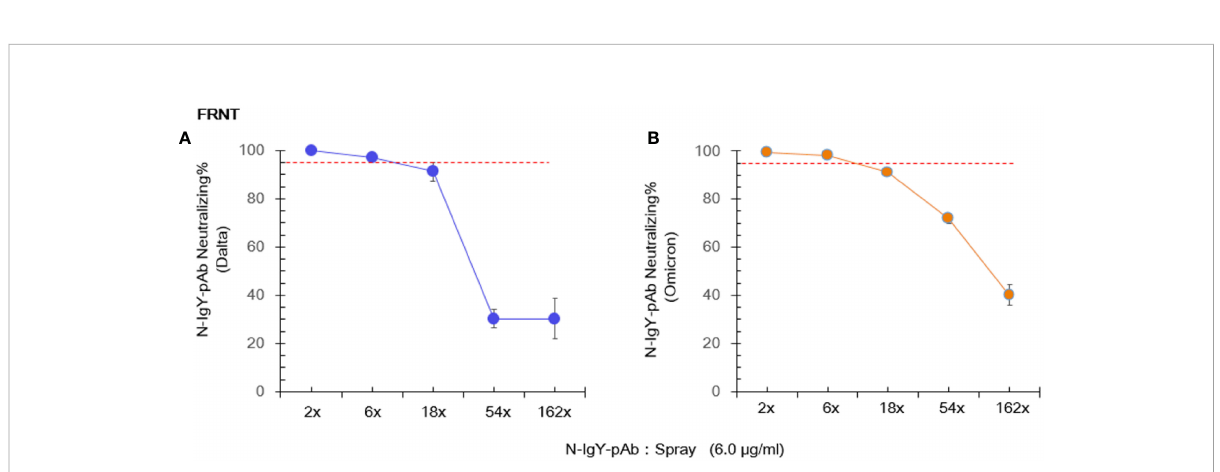
m, month. ThestabilitywastestedinanELISAcoatedbyRBDorS-ECD.ThemeanandSDvalues werebasedon20repeatedtestsatthestoragetimefromday0today7at37°C,oratthestorage time from 0 to 12 months at 4°C. The values were expressed as